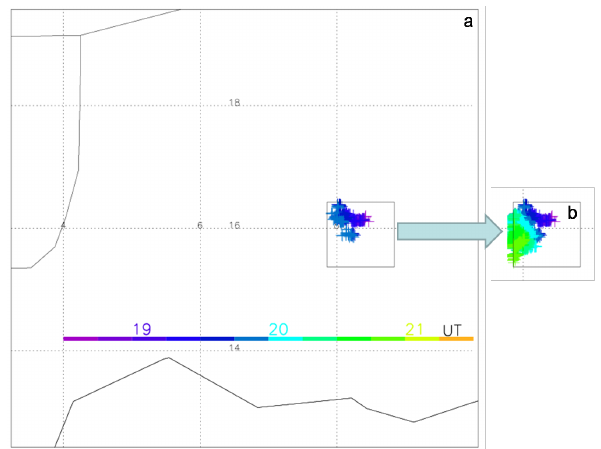
Fig. 11 Fig. 11. Same as Fig. 8 but for the A¨ır case. The same color scale as in Fig. 5 is chosen. (a) Zoom on Grid 3 from 18:30 to 19:50UT. (b) From 18:30UT to